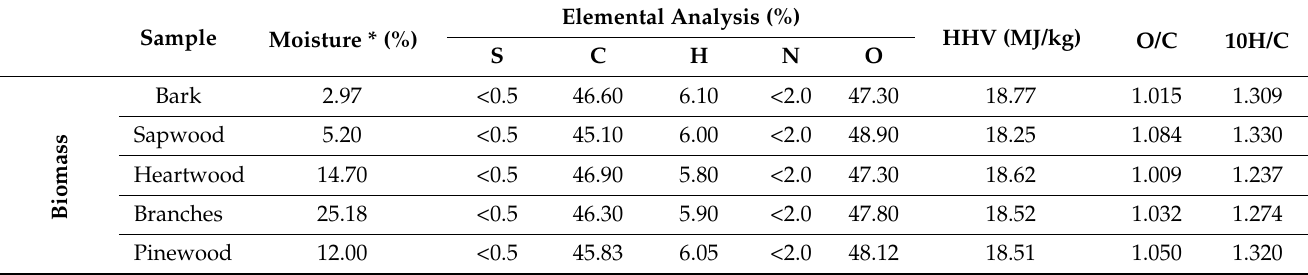
Table 1. Elemental analysis of pinewood biomass samples collected in Leiria National Forest.